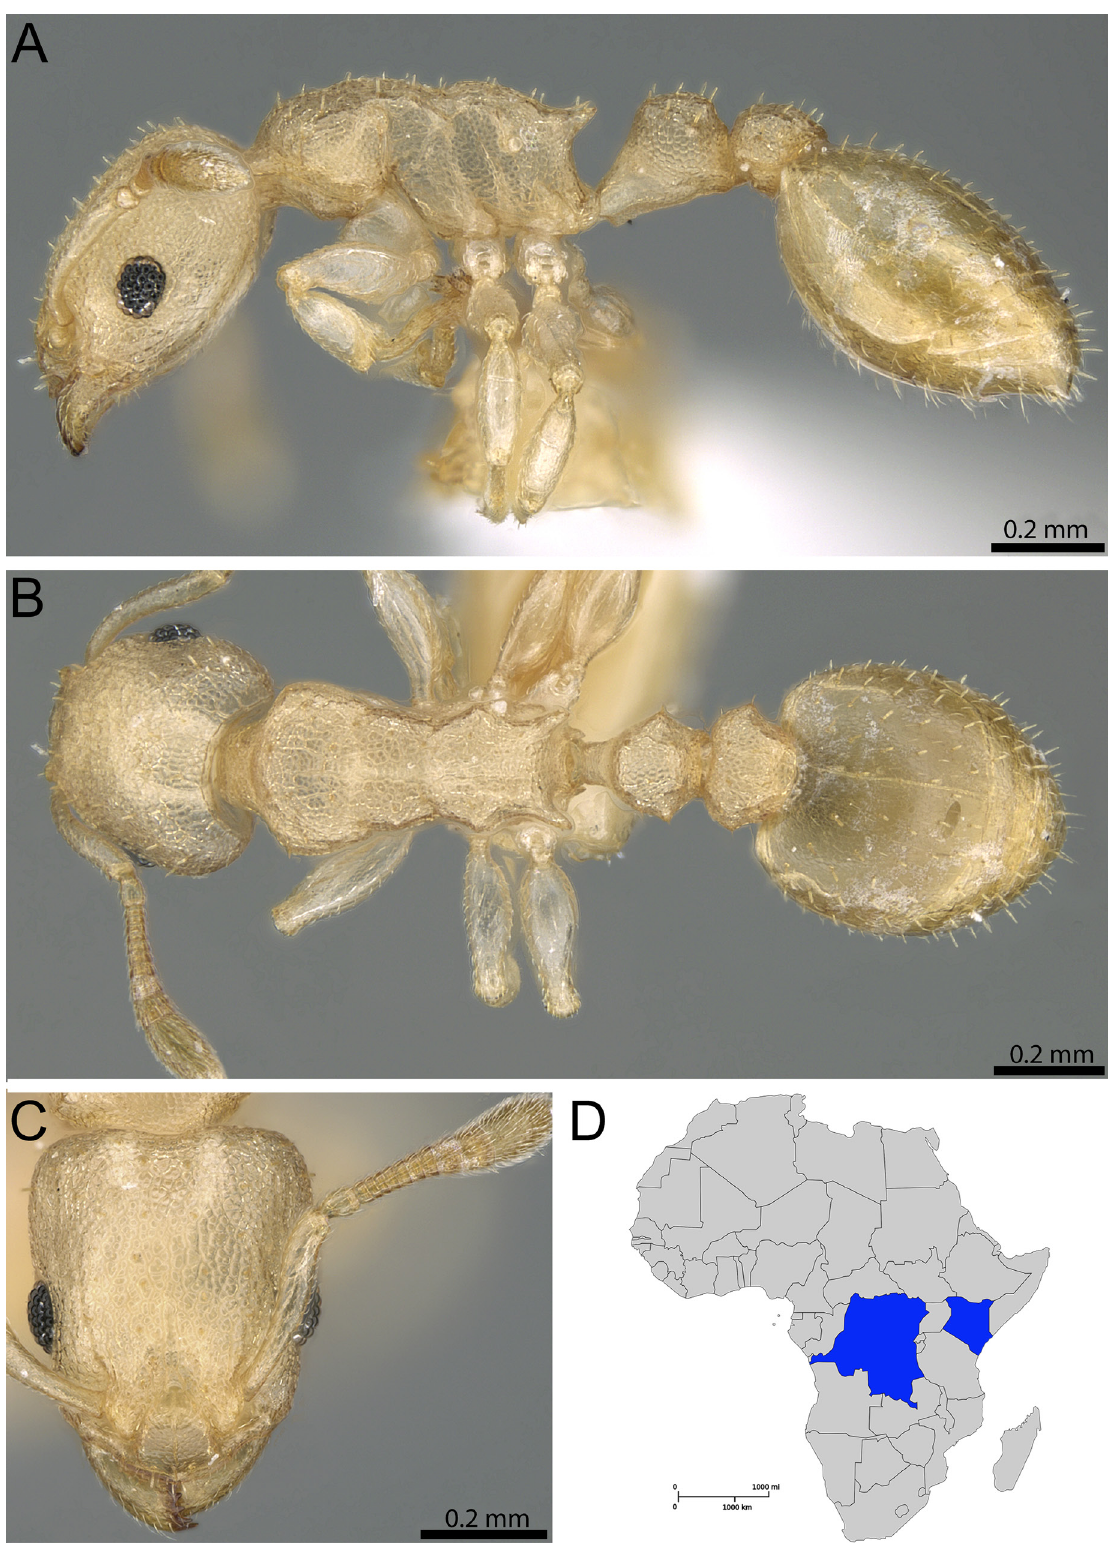
Fig. 19. Nesomyrmex innocens (Forel, 1913) (CASENT0906195). A . Body in profile view. B . Body in dorsal view. C . Head in full-face view. D . Map of Africa and Madagascar showing currently known